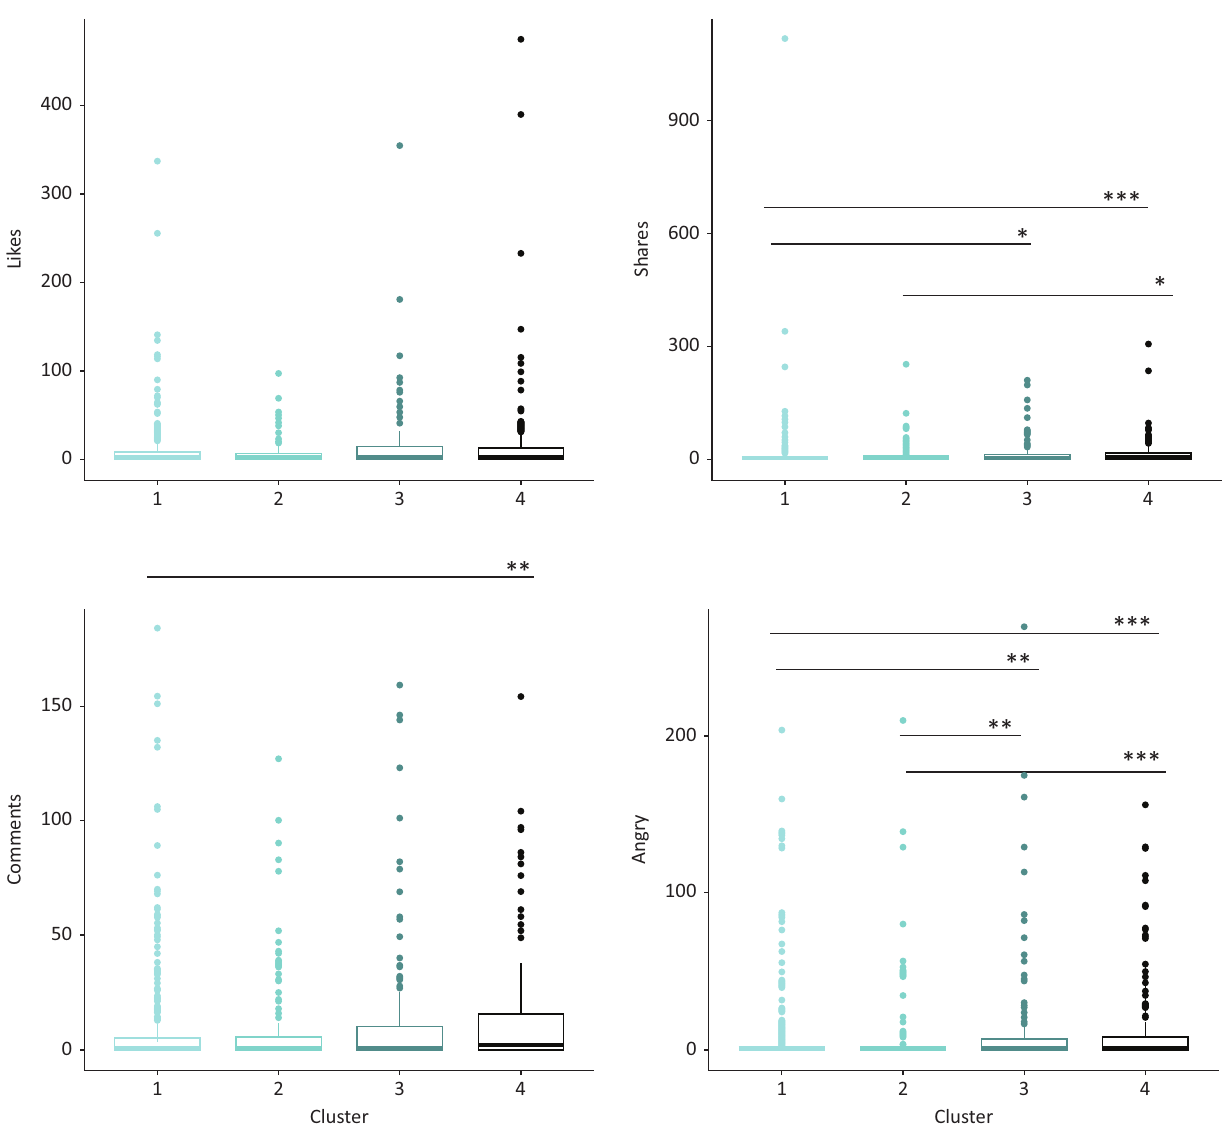
Figure 2. Engagement per cluster. Notes: The boxplots show the median and the interquartile range; the single dots visu‐ alize datapoints outside this area; Cluster 1 = alternative views; Cluster 2 = absolutist ideologies; Cluster 3 = mobilization; Cluster 4 = wrath; single comparisons are indicated via horizontal lines; *** p < .001, ** p < .01, * p <